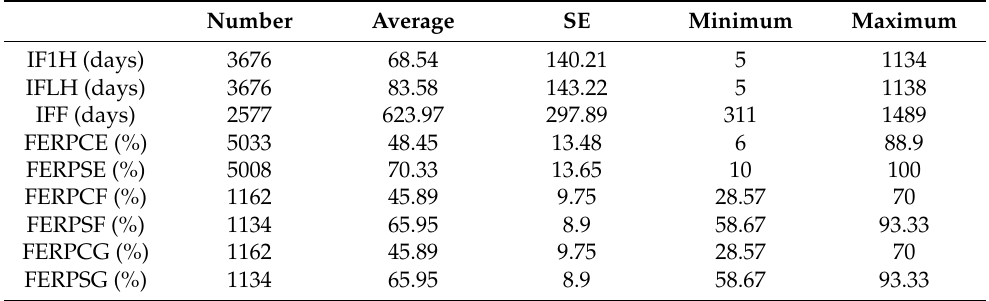
Table 1. Breeding performance of stallions. IF1H: the interval between foaling and the 1st mating (heat), IFLH: the interval between foaling and the last mating, IFF: the interval between two foalings, FERCE: fertility per cycle of stallion, FERPSE: end-of-season fertility of stallion, FERPCF: father’s fertility per cycle, FERPSF: end-of-season fertility of father, FERPCG: grandfather’s fertility per cycle, FERPSG: end-of-season fertility of